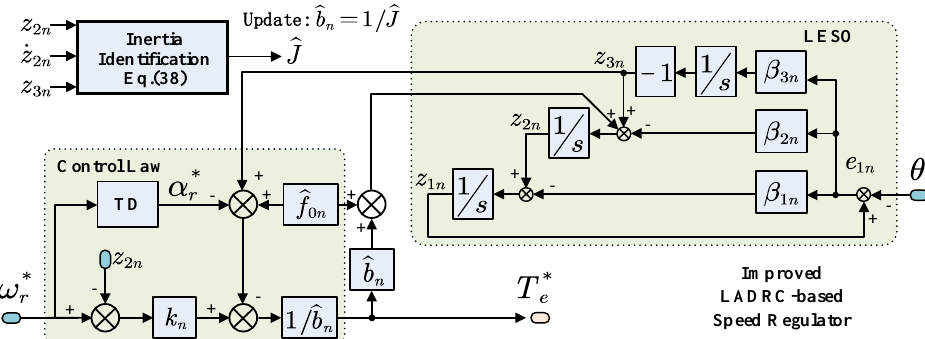
Figure 10. Block diagram of the improved LADRC-based speed regulator.